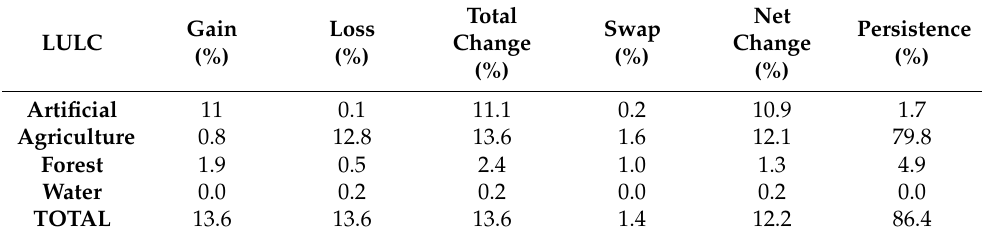
Table 4. Land use change parameters, period of time: 1956–2018. Rebollos watershed. Table 5. Land use change parameters, period of time: 1956–2018. Miranda watershed. LULC LULC